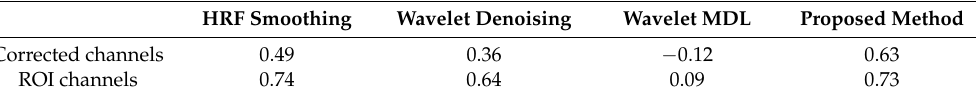
Table 2. Motion artifact correction performance achieved using the conventional and proposed